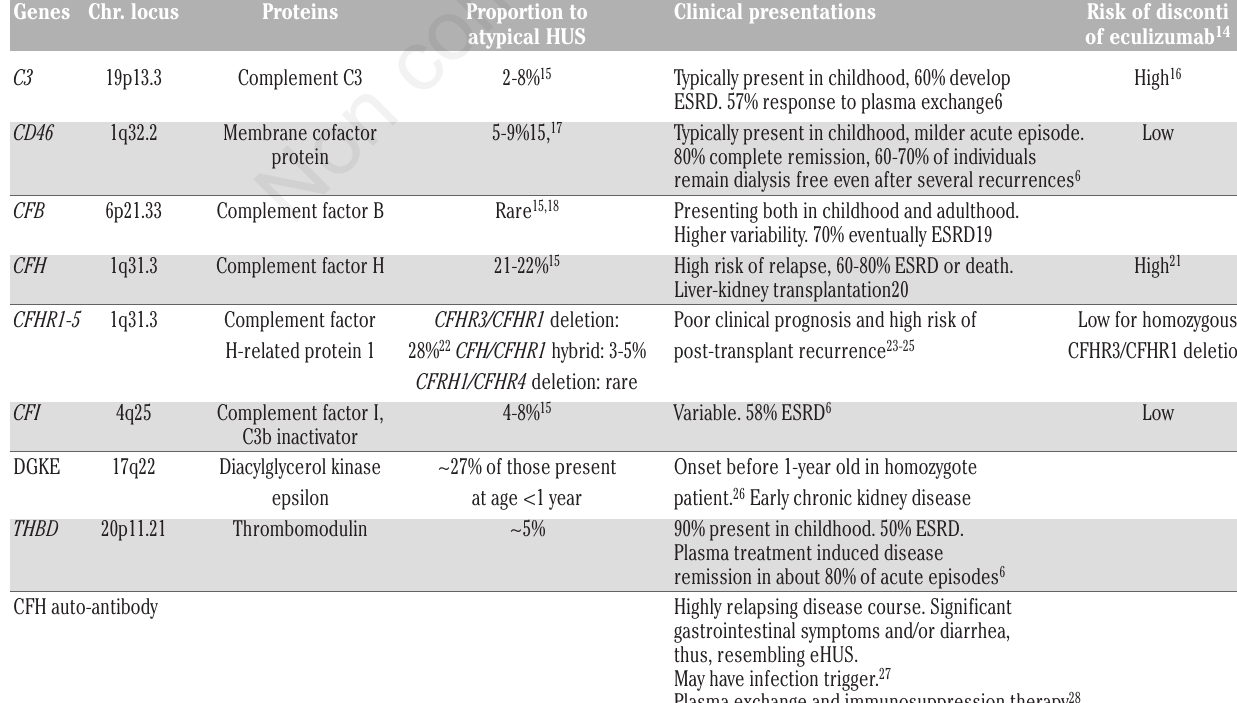
Table 1. Atypical hemolytic uremic syndrome: genetic contributions, clinical presentations and risk of discontinuation of eculizumab. Genes Chr. locus